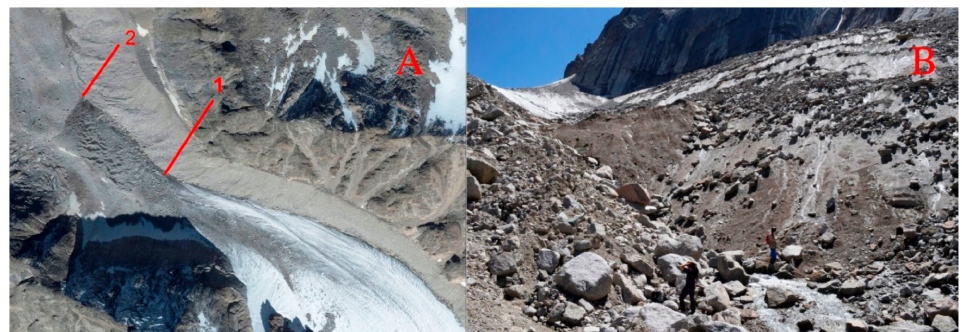
Figure 2. The snout of Grigor’eva glacier, Chikhacheva ridge. ( A ) The apparent ( 1 ) and the actual ( 2 ) lowest points of the glacier; ( B ) a photo of the actual glacial lowest